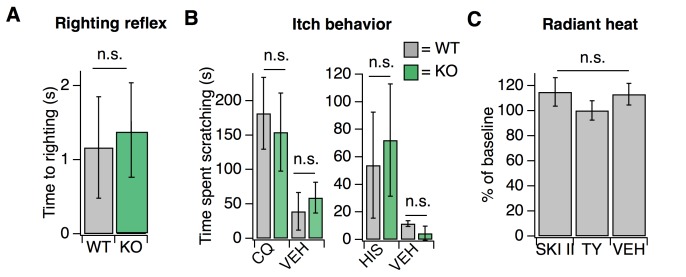
Loss of S1PR3 selectively impairs mechanonociception.Related to Figure 1. (A) Time to righting in seconds for P7 pups per genotype for WT and KO mice; p=0.575 (two-tailed unpaired t-test; N = 7 mice per genotype). (B) (Left) Time spent scratching in response to injection of 50 mM chloroquine or PBS vehicle (VEH) in WT and KO mice; p=0.36, 0.98, (unpaired t-tests; N = 3–4 mice per group). (Right) Time spent scratching in response to injection of 27 mM Histamine or 0.1% DMSO-PBS in WT and KO mice; p=0.51, 0.06 (unpaired t-tests; N = 3–4 mice per group). (C) Normalized paw withdrawal latencies post-injection of SKI II, TY 52156, or 0.1% DMSO-PBS vehicle into the hind paw of wild-type animals; p=0.65 (one-way ANOVA; N = 5 mice per group). Unless otherwise indicated, error bars represent mean ± SD.